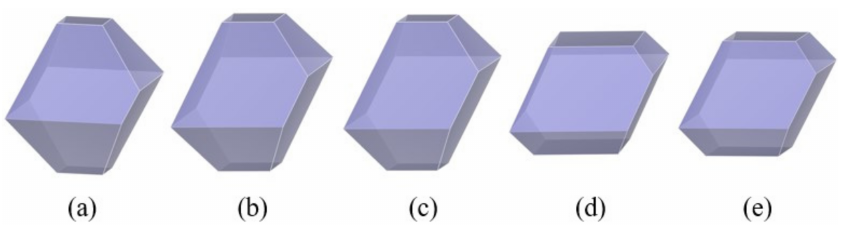
Figure 7. Simulation of β -HMX crystal morphology in PVA–DMSO system with different mass fractions of PVA at 298 K. ( a ) 0.5%, ( b ) 1%, ( c ) 3%, ( d ) 5%, and ( e )